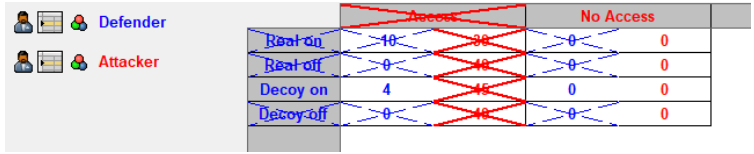
Figure 4. Results of the dominance for N 10 .